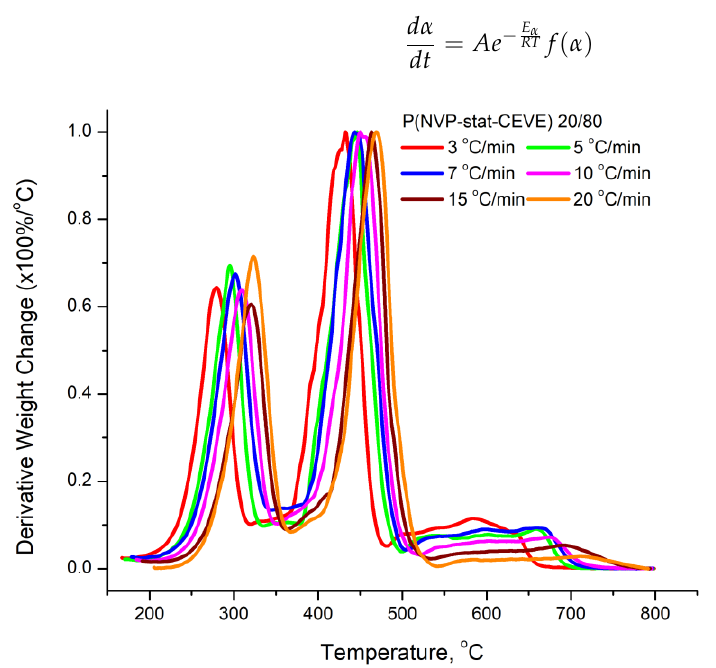
Figure 6. Derivative weight loss with temperature under different heating rates for the P(NVP – stat – CEVE) 20/80.